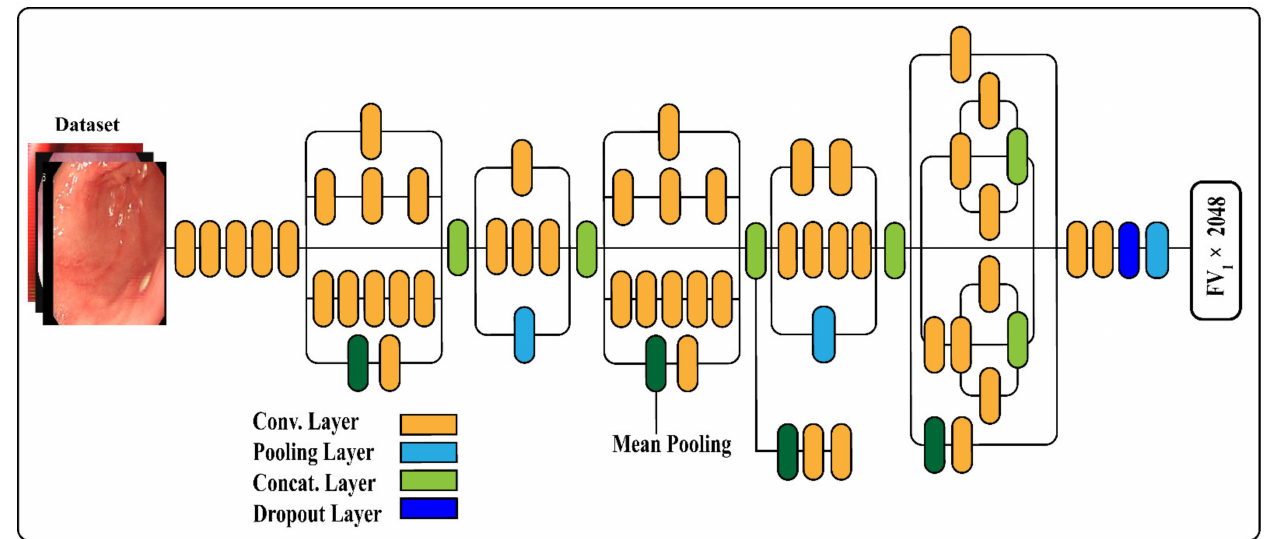
Figure 4. Transfer-learning formation of Inception V3 for feature